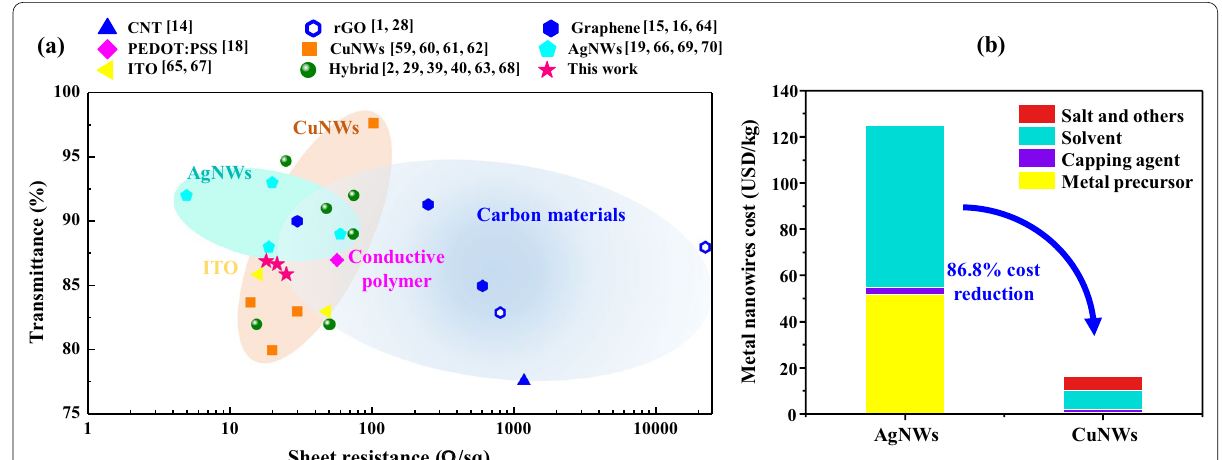
Fig. 7 a Optoelectronic performances of selected state‑of‑the‑art flexible TCFs. b Price analysis of preparation of the CuNWs and AgNWs. The total price is divided into four parts (metal precursor, capping agent, solvent, salt and other chemicals), which clearly show that the fabrication of CuNWs is more